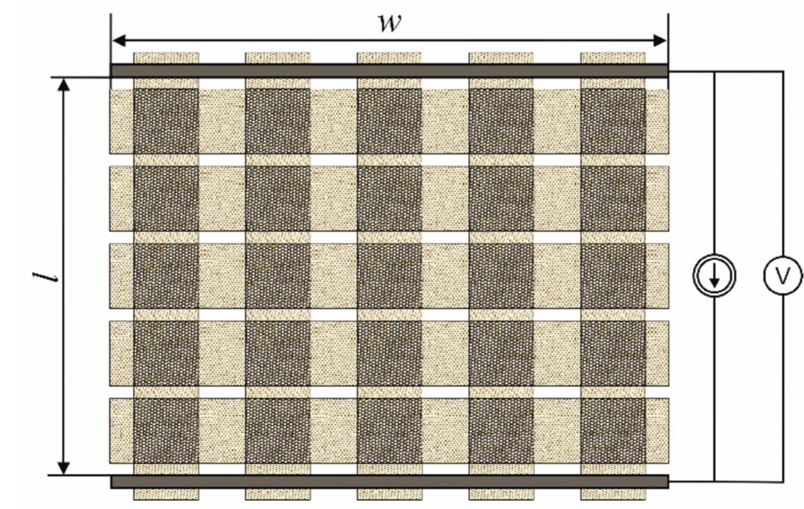
Figure 4. Woven structure resistance measurements (the top